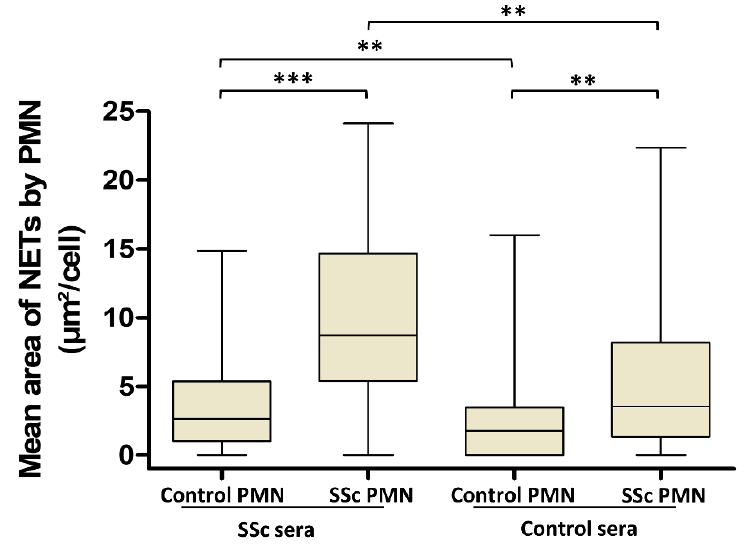
Figure 2. Polymorphonuclear neutrophils (PMN) and serum are both involved in SSc NETosis. To analyze the respective role of cells and sera in NETosis, PMN from SSc patients were stimulated with autologous sera (n = 34) or with sera from the controls (n = 52), and PMN from controls were stimulated with autologous sera (n = 26) or with sera from SSc patients (n = 151). All stimulations were performed in duplicate. The mean area of NETs released by PMN is represented by a “box and whiskers” plot for each condition tested. Boxes show the 25–75th percentiles, lines show the median value, and whiskers show the range of the mean area of NETs released by PMN. *** p < 0.001, ** p < 0.01.